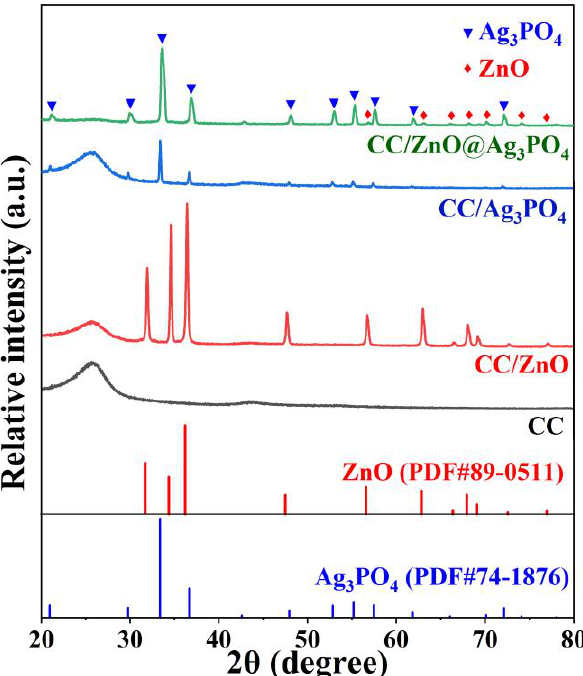
Figure 2. XRD patterns of the CC, CC/ZnO, CC/Ag 3 PO 4 , and CC/ZnO@Ag 3 PO 4